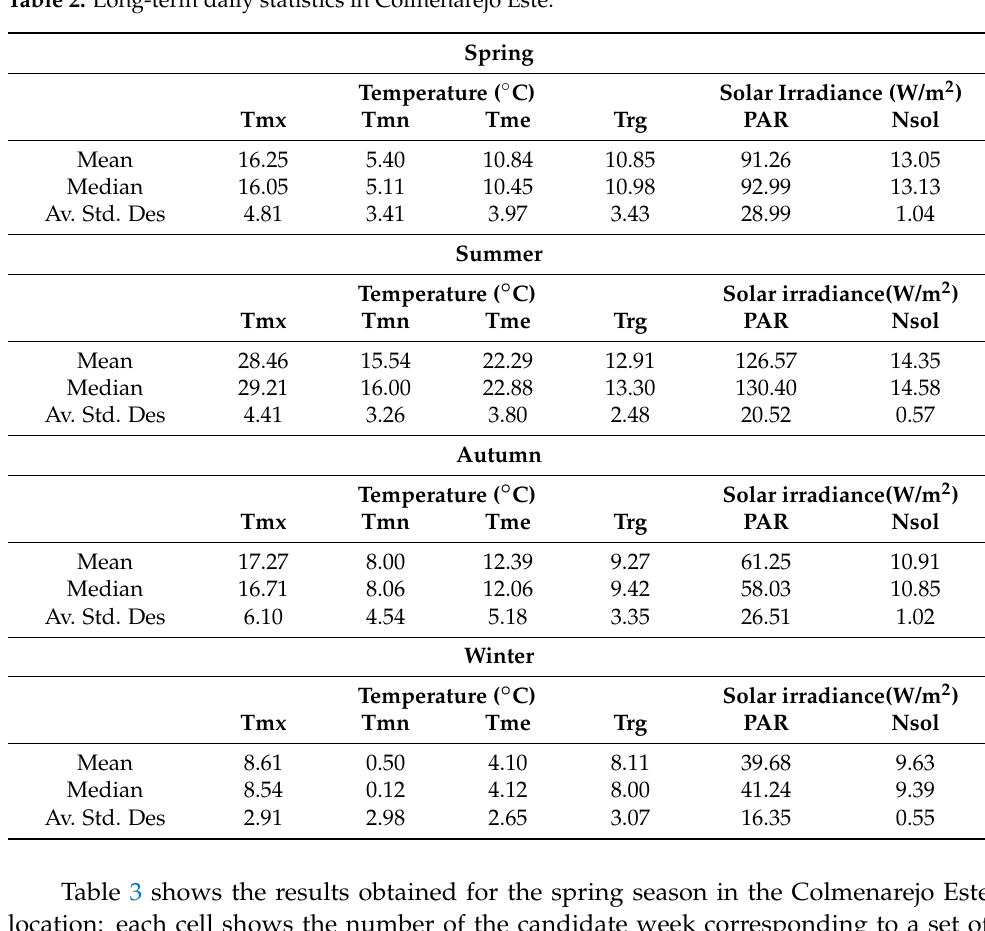
Table 2. Long-term daily statistics in Colmenarejo